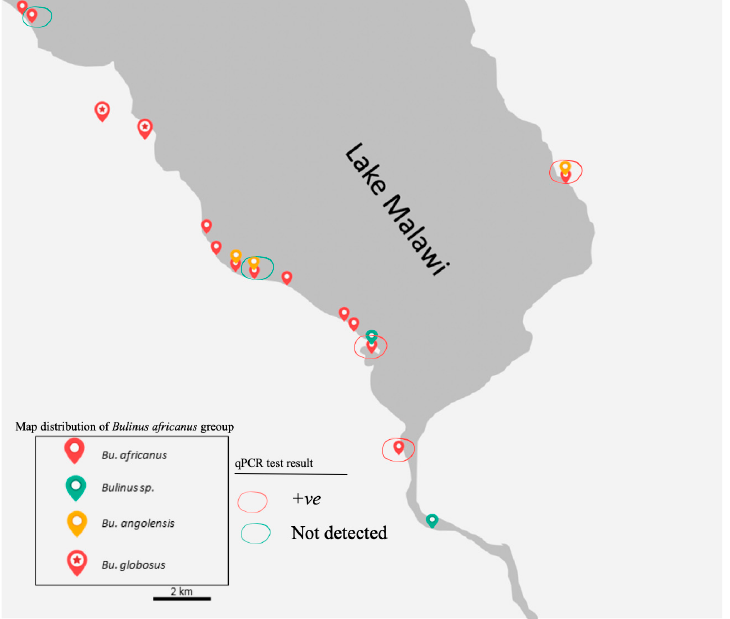
Figure 4. Map of the distribution of the B. africanus group on the southern shoreline of Lake Malawi and its connected water bodies visited between 2017 and 2018. The red circle indicates samples were positive (+ve) for real-time PCR, while the green circle indicates samples where DNA of Schistosoma were not detected within snail. Previously all snails were thought to be B. globosus. 3.3. The Prevalence of Schistosoma DNA within B. africanus Group A total of 30 of the 106 Bulinus snails (28.3%) were positive to the Schistosoma -specific screen using real-time PCR methods. DNA Schistosoma were detected in B. africanus and B. angolensis samples in eastern and southern shores of the Mangochi District. The posi- tives samples were collected from the Lake and connected waterbodies.